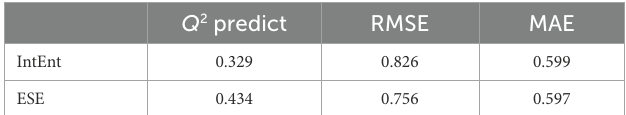
TABLE 7 Q 2 predict test.